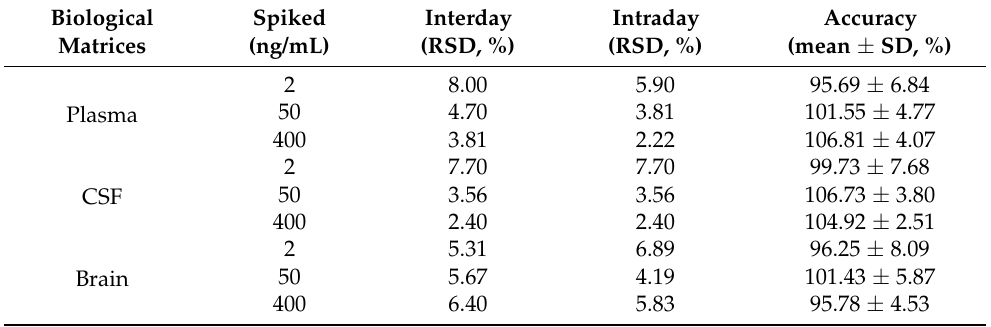
Table 1. Inter- and intraday precision and accuracy for 5-CQA in rat biological samples ( n = 5).